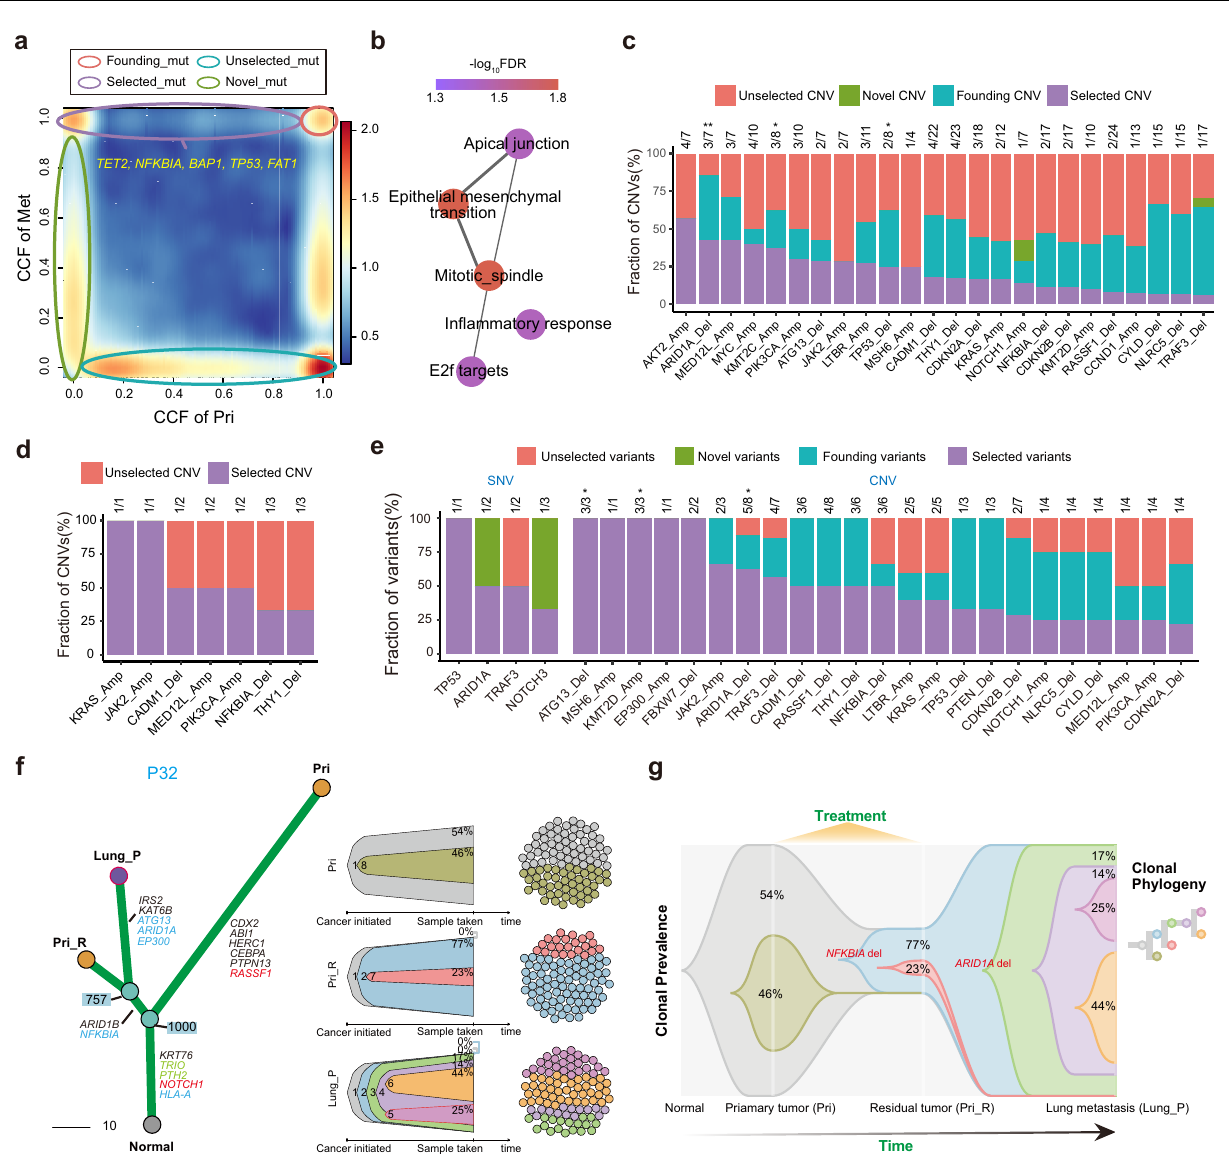
d Distribution of variant groups during progression according to the key CNVs betweenpairedprimarytumoursandresidualtumouraftertreatment.Thenumber of selected variants is annotated. e Distribution of variant groups during progres- sionaccordingtokeyvariants,including SSNVsand CNVs,betweenpaired primary tumour samples and posttreatment progressed metastatic samples. f The evolu- tionary landscape of P32. The left panel shows the phylogenetic tree with the key variants highlighted. The right panel shows the subclone-based evolution archi- tectureofeachsampleandtheirsamplingtransect,whichre fl ectstheproportionof each subclone at the time of sampling. g Dynamic subclone-based evolution architectureofP32plottedusingTimeScape,withtheproportionofeachclusterat the time of sampling annotated. Source data are provided as a Source Data fi